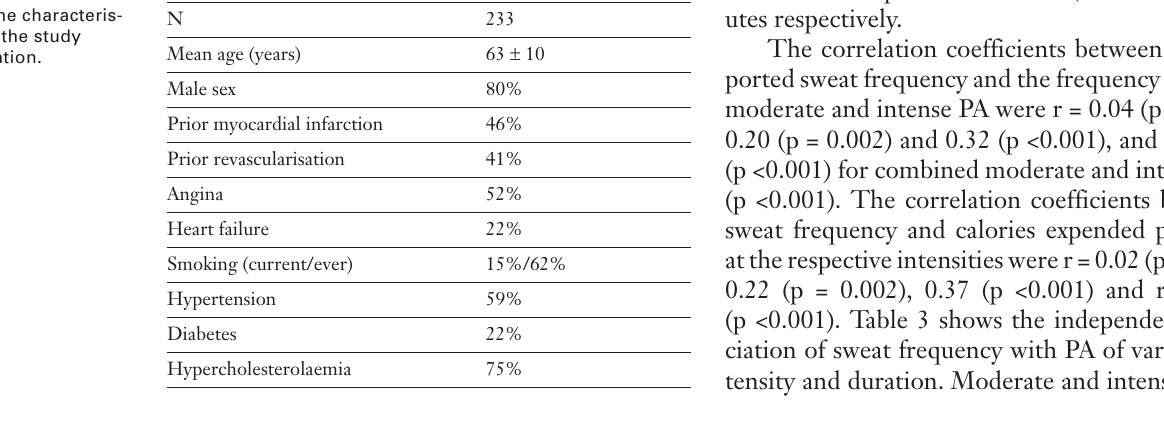
Frequency of exer- cise-induced sweat- ing and different physical